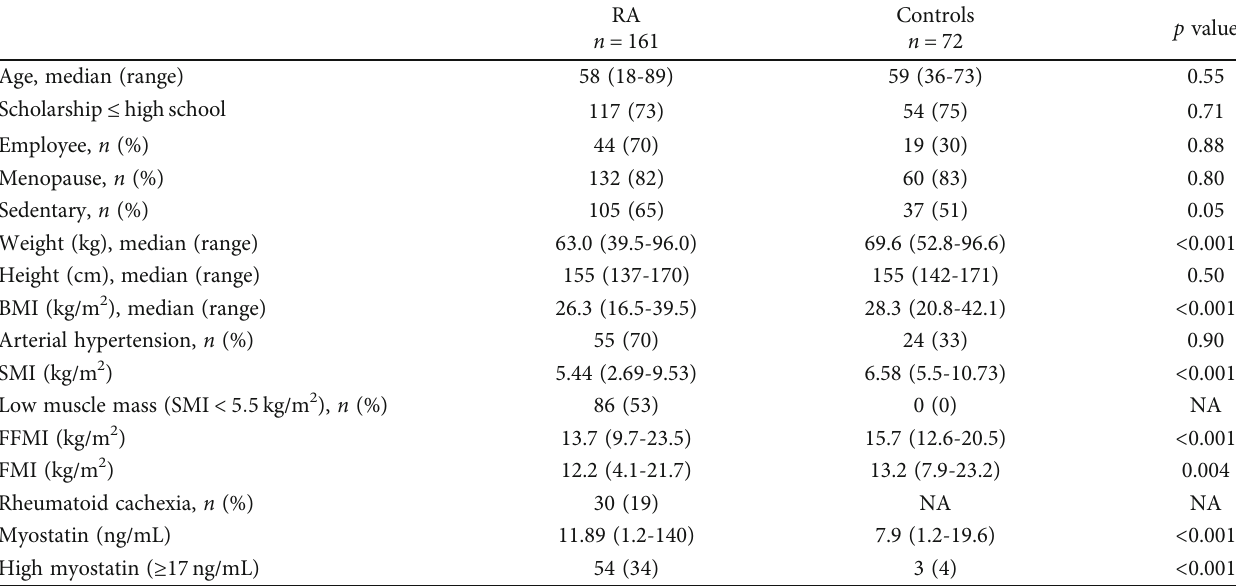
Table 1: comparison between selected characteristics of patients with RA vs controls.